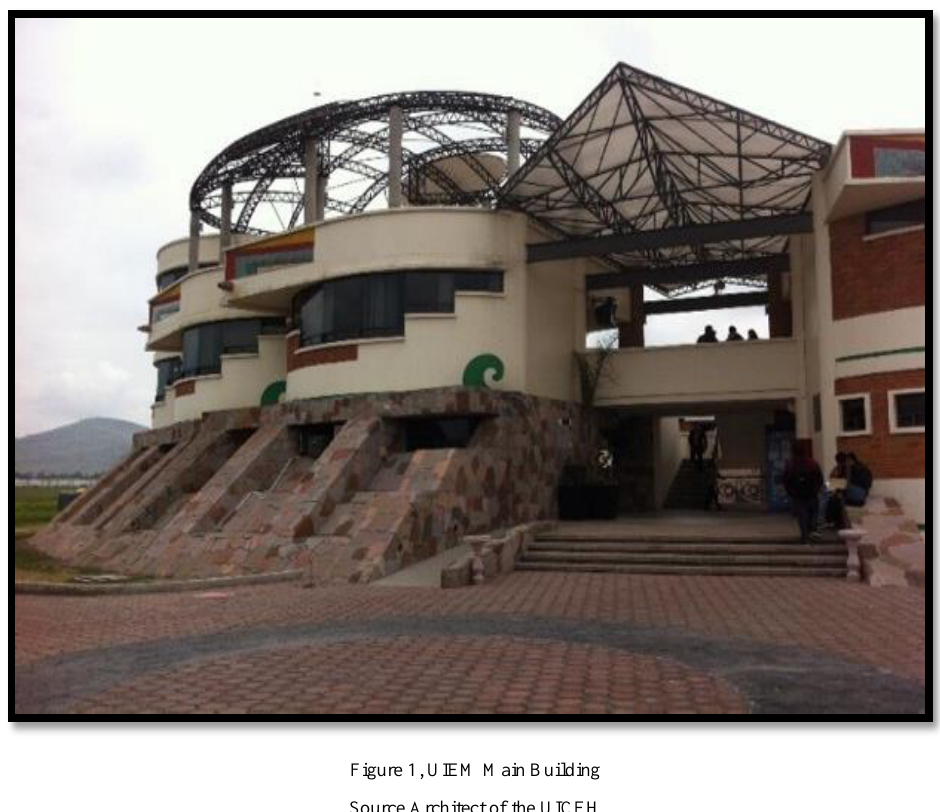
Figure 1, UIEM Main Building Source Architect of the